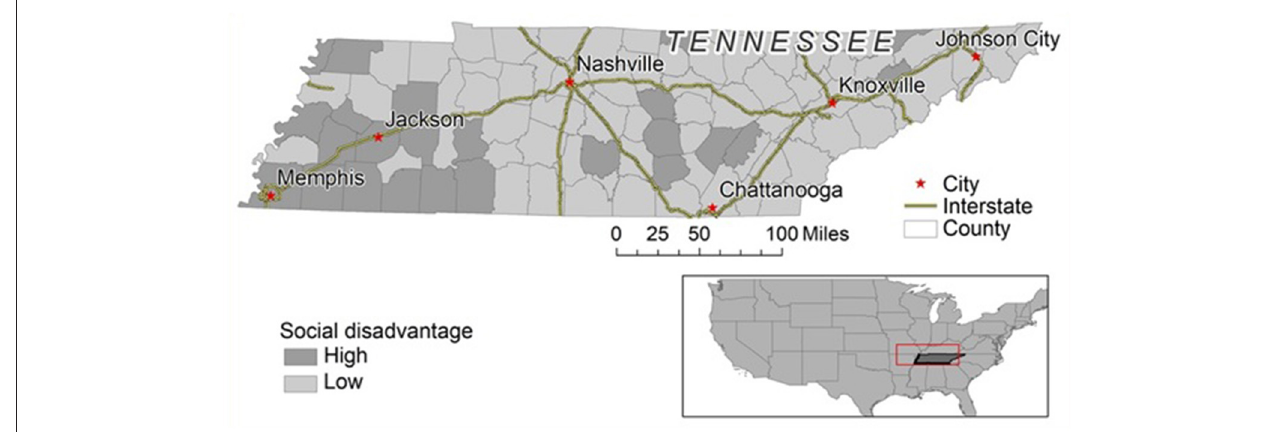
FIGURE 3 | Counties with high and low social disadvantage in TN.